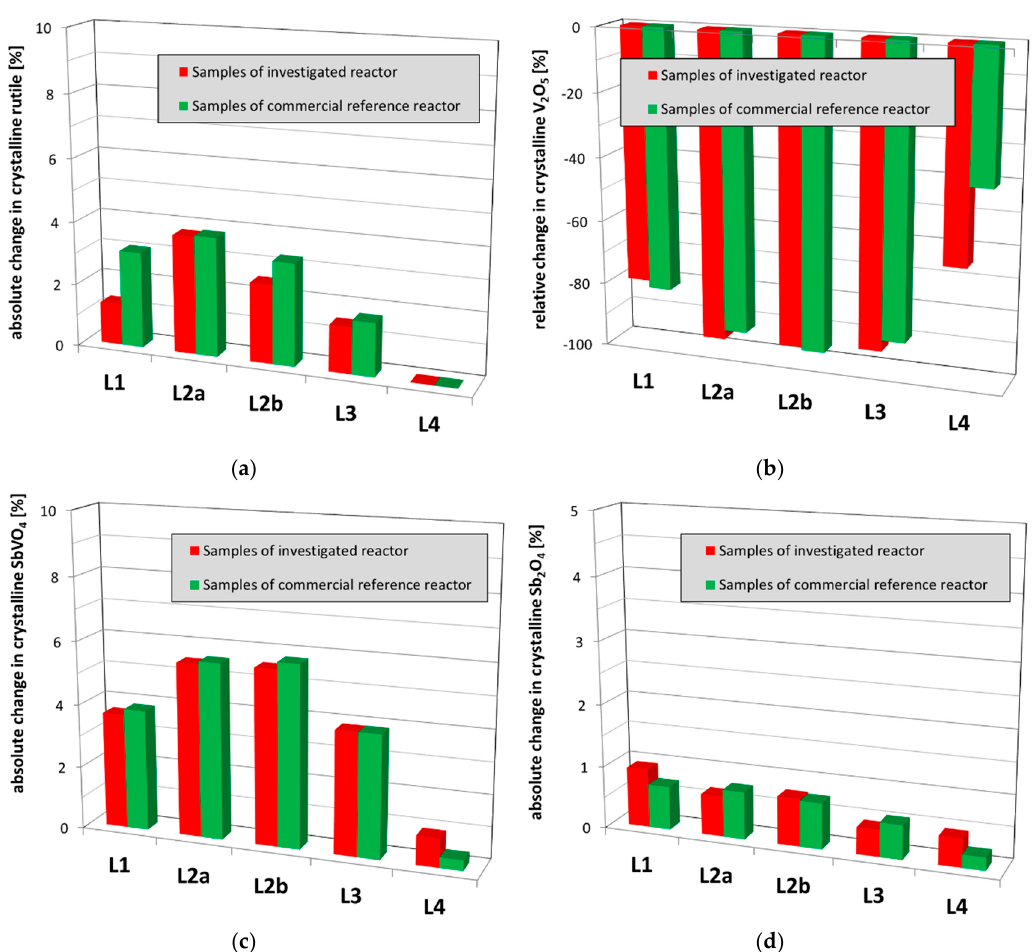
Figure 6. Comparison of the crystalline phase composition of used catalyst samples from the investigated reactor and the commercial reference reactor: ( a ) absolute changes in crystalline rutile; ( b ) relative changes in crystalline V 2 O 5 ; ( c ) absolute changes in crystalline SbVO 4 ; ( d ) absolute changes in crystalline Sb 2 O 4 . The samples of each layer were averaged.